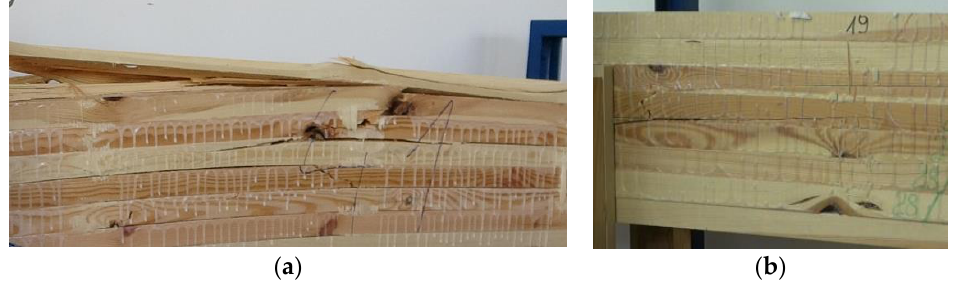
Figure 7. Beam failure images: ( a ) GL24c—MOR(MOR 12% )—48.5(43.4) N/mm 2 —the strongest in the group, ( b ) GL28c—MOR(MOR 12% )—30.4(25.8) N/mm 2 —the weakest in the group.